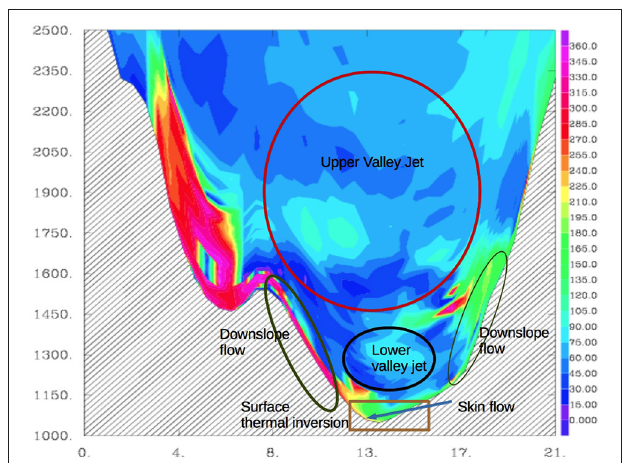
FIGURE 2 | Vertical cross-section of the wind direction for a simulation of La Cerdanya valley in the Pyrenees, for a cross valley direction at night. Some main structures are indicated. The vertical scale is in meters and the horizontal scale in kilometers.